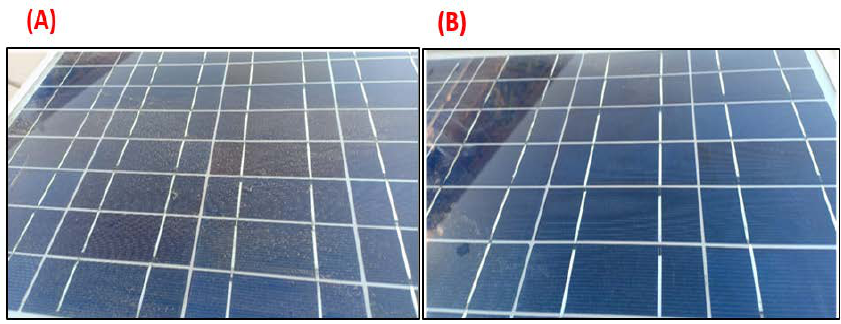
Figure 12. Anti-static effect of the solar PV panels. ( A ) non-coated panel (reference panel) ( B ) hydrophobic nano-coating SiO 2 material on the PV panel.